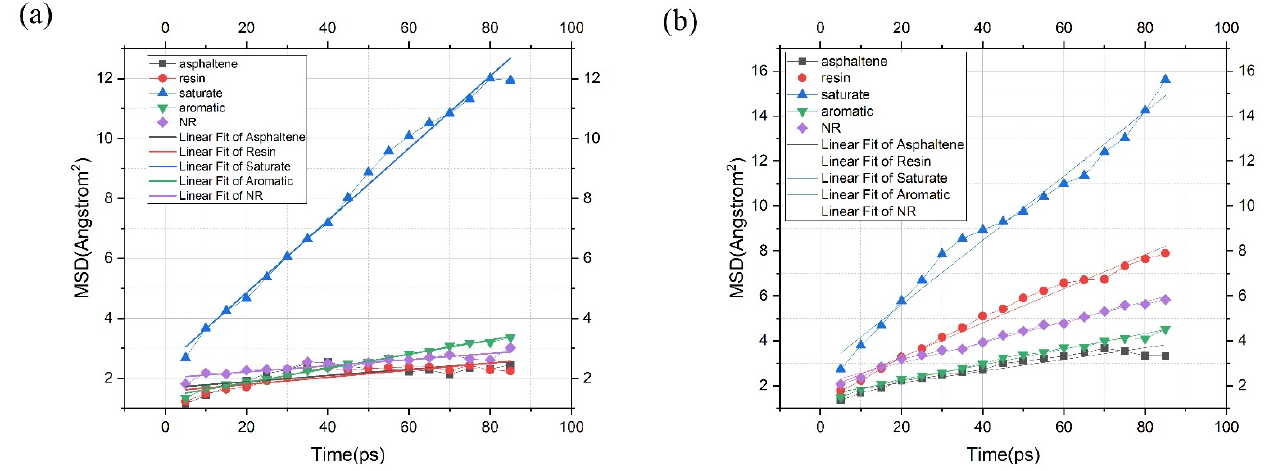
Figure 8. 𝑀𝑆𝐷 for modified asphalt ( a ) NR-modified asphalt; ( b ) PE/NR-modified asphalt. For the NR-modified asphalt system, the diffusion coefficient of NR is the